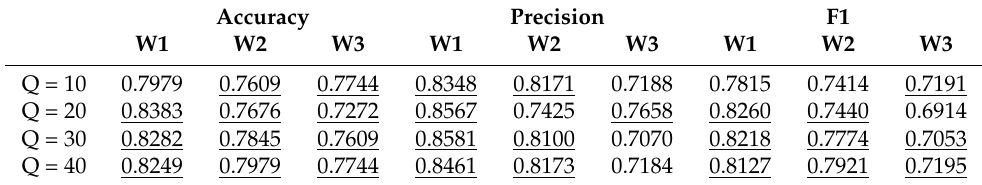
Table 2. Evaluation of W1, W2 and W3’s personalized models generated with 20% AL dataset bias after Q = 10,20,30,40 queries, using their corresponding evaluation datasets. Underlined results mean increased metrics in comparison with the corresponding FL